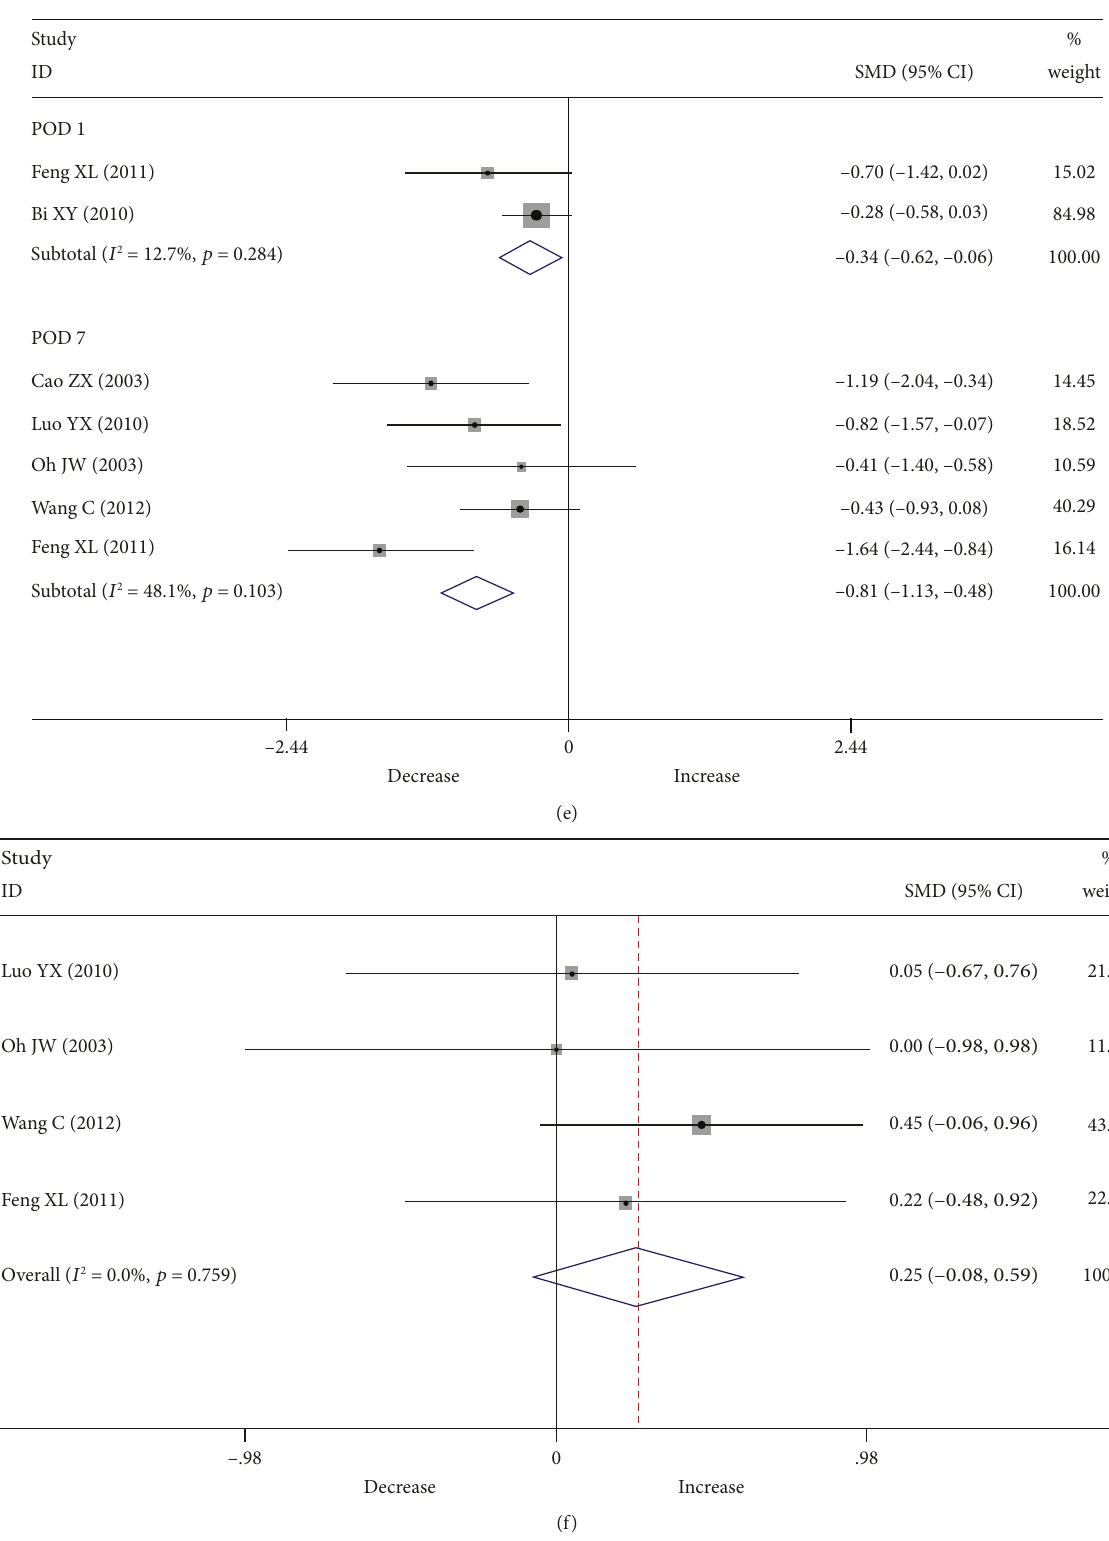
Figure 2: Meta-analysis of comparison between the HS and HA groups for the (a) DFS rate, (b) OS rate, (c) WBC count at POD 7, (d) PLT count at POD 7, (e) T-Bil content at POD 1 and 7, and (f) ALB content at POD 7. Abbreviations: HS: simultaneous hepatectomy and splenectomy; HA: hepatectomy alone; DFS: disease-free survival; OS: overall survival, WBC: white blood cell; PLT: platelet; T-Bil: